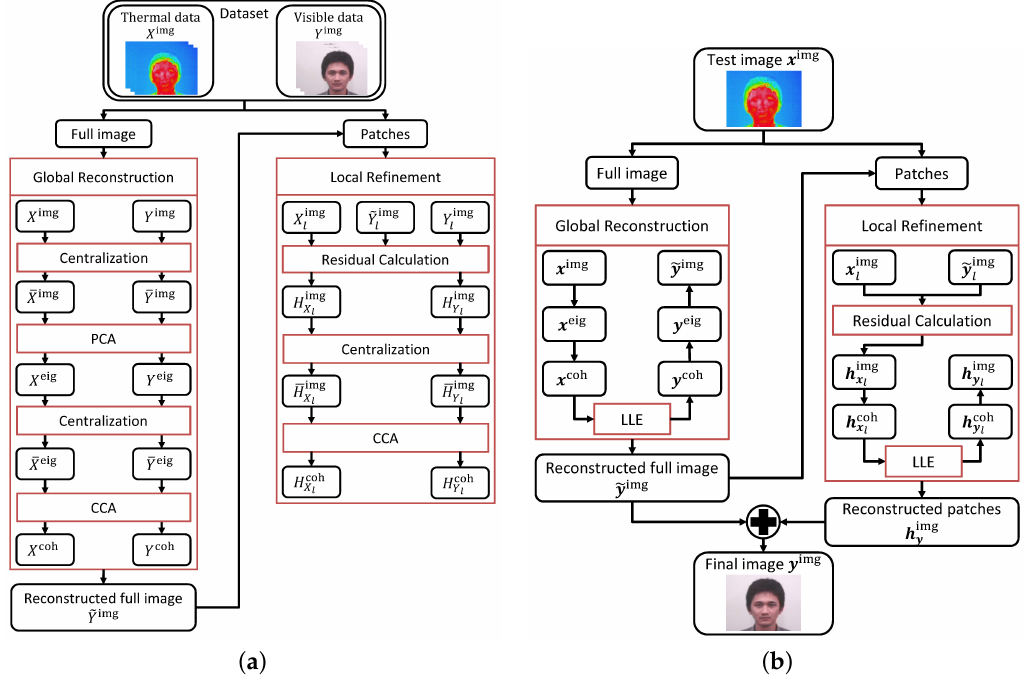
Figure 2. Process flow of the proposed method: ( a ) training process; ( b ) reconstruction